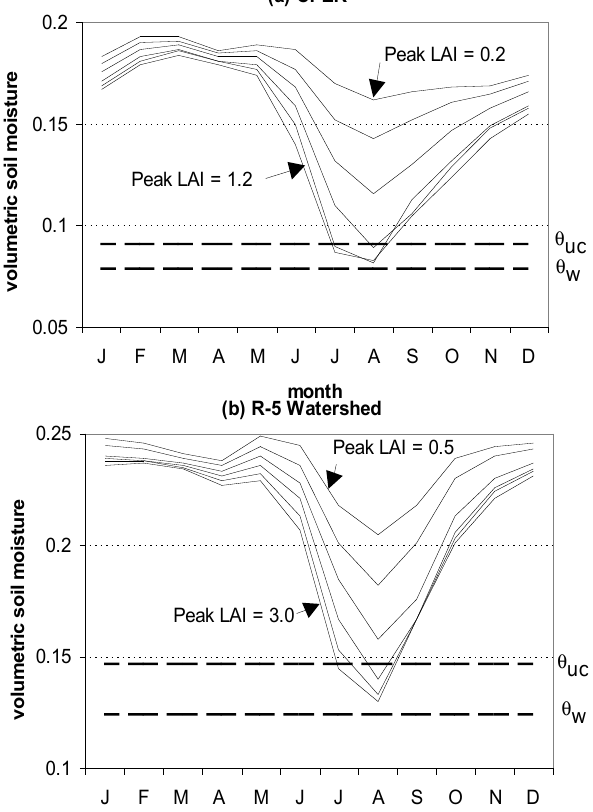
Fig. 8. Sensitivity of modeled root zone soil moisture to the peak in green LAI for: (a) the CPER sandy loam slope in LAI increments of 0.2, and (b) the R-5 watershed in LAI increments of 0.5.